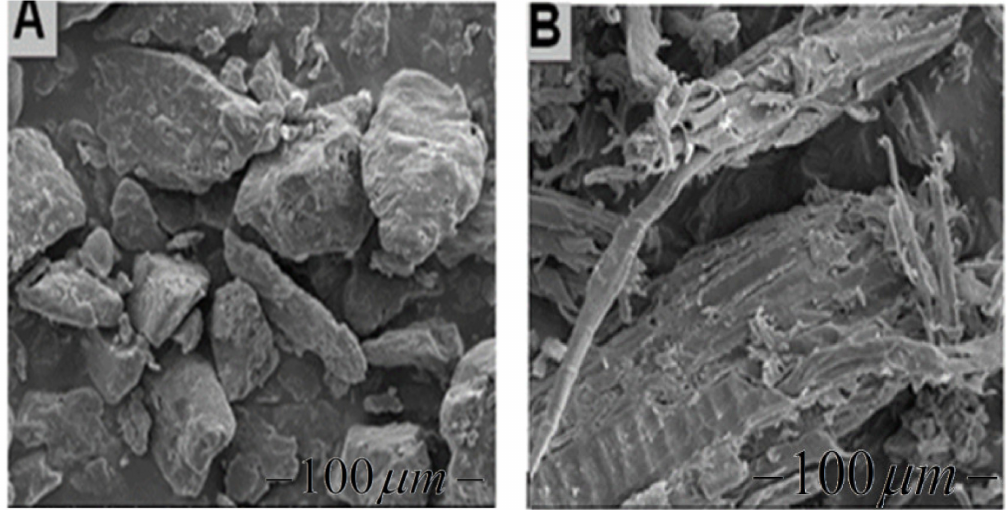
Figure 5. Surface morphology of ( A ) the PES powder and ( B ) the